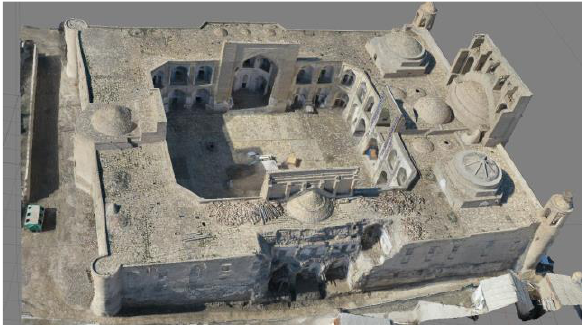
Figure 13. 3D model of Abdulazizkhan Madrasah. See collapsed wall in the lower centred part. Source: